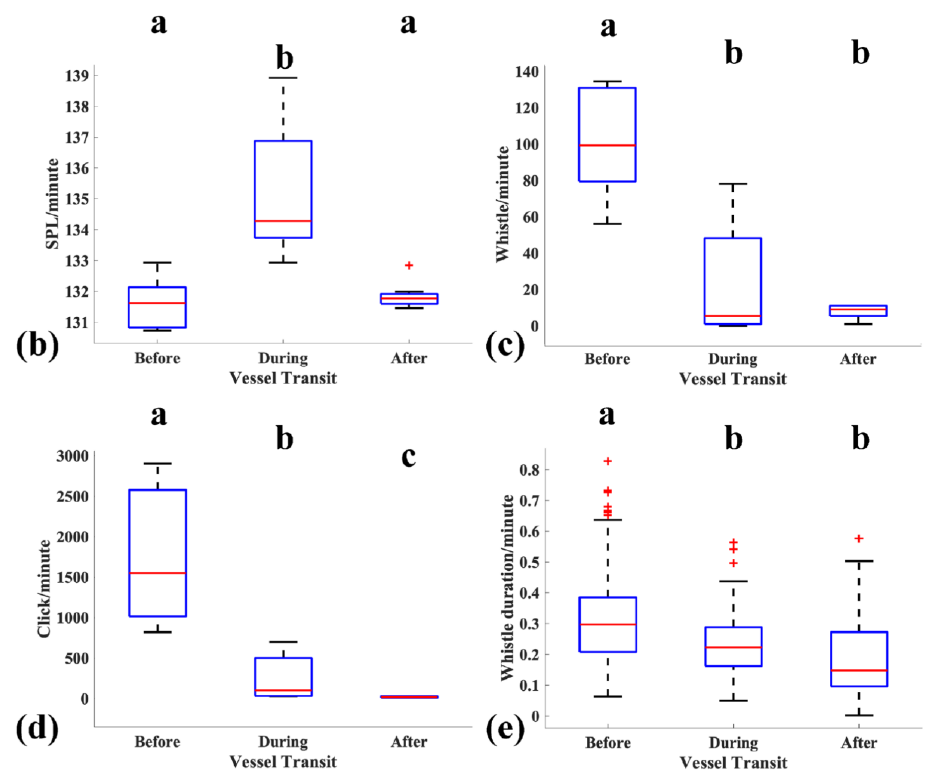
Figure 3. ( a ) Frequency of whistle types per minute (number of replicates in group, whistle Type 1–7; n = 16, 36, 45, 27, 49, 22, and 18, respectively). Effect of vessel transit (before [ n = 9 min], during [ n = 7 min], and after [ n = 9 min]) on ( b ) Sound pressure level (SPL, dB re 1 μ Pa), ( c ) number of whistles, ( d ) number of clicks, and ( e ) whistle duration (s) within a minute. The central red mark on each box indicates the median, and the top and bottom edges of the box represent the 25th and 75th percentiles. The maximum and minimum values are marked in black at the extreme ends. The symbol ‘+’ indicates the outliers. Superscript letters represent results of the post hoc multiple comparison test; different superscript letters indicate significant differences ( p < 0.05), with letter ‘a’ at the top, and subsequent statistical differences are represented at a lower